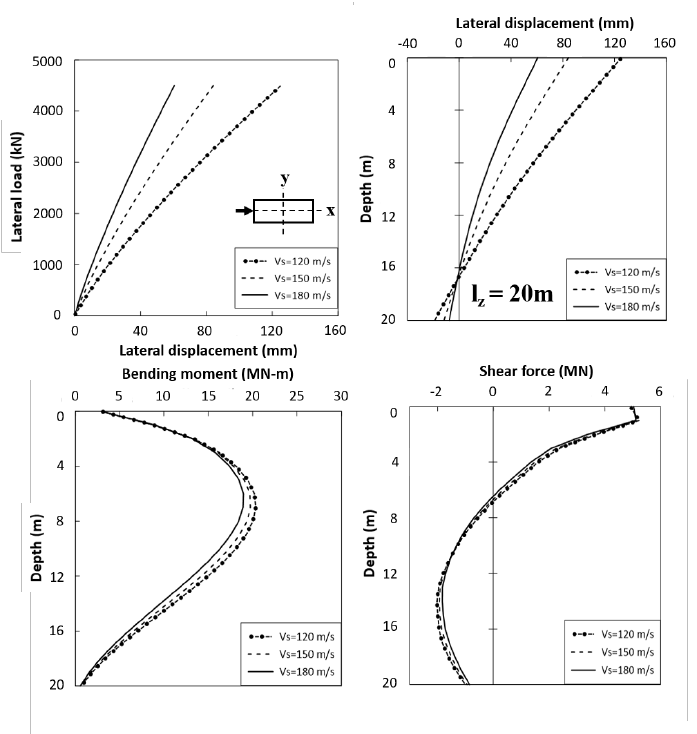
Fig. 12. Performance of 20m barrette in sands with load applied in longitudinal